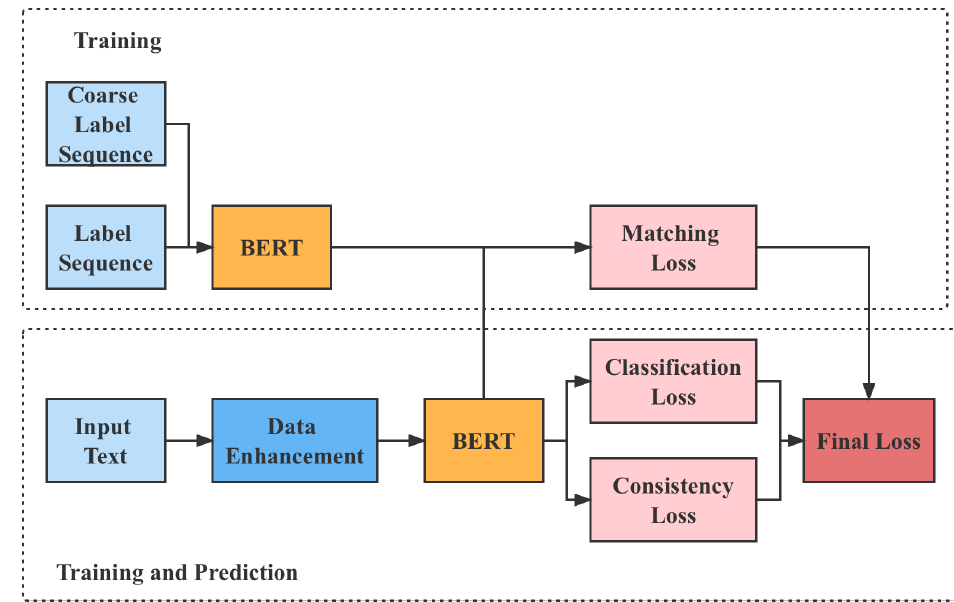
Figure 8. The structure of the classification